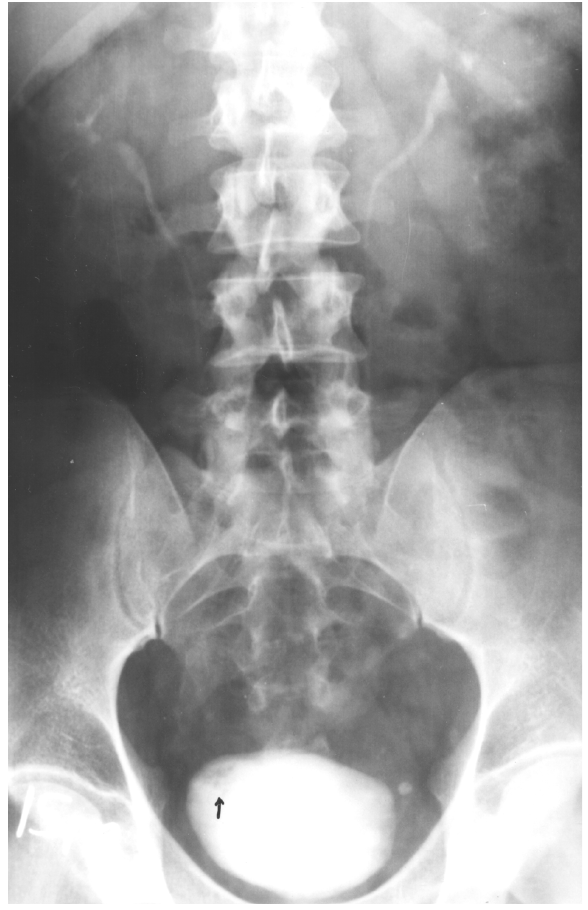
Figure 3 – An intravenous urogram showing a small papillary tumor as filling defect in the right lateral wall of urinary bladder.